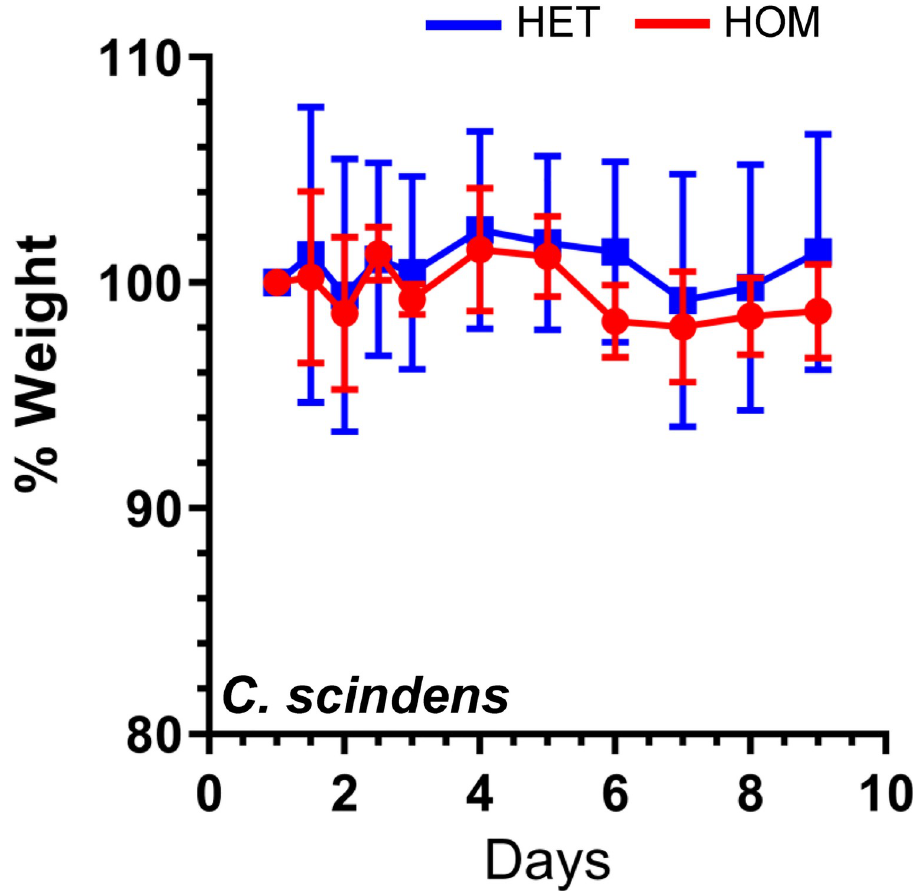
Fig 5. Cholic acid derivatives are not required for protection against CDI. C . scindens -monoassociated CYP8B1 +/- (N = 3) and CYP8B1 -/- (N = 4) mice were infected with C . difficile VPI10463 and monitored for signs of disease.